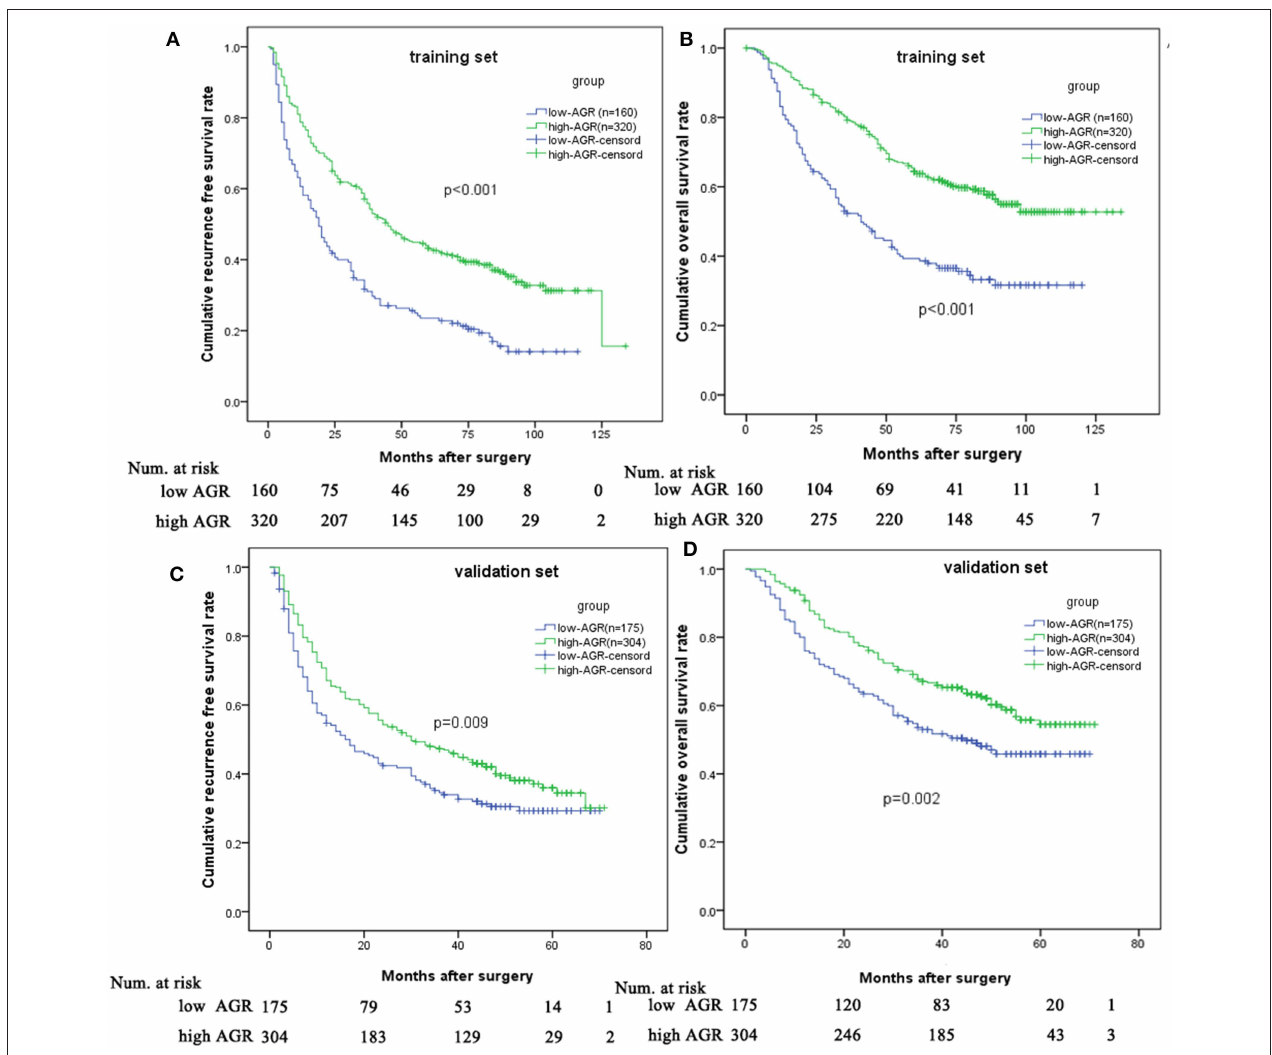
FIGURE 3 | Comparison of prognosis between low and high AGR group in the training set and validation set. Low AGR group had worse RFS (A) and OS (B) in the training set and validation set (C,D) than high AGR